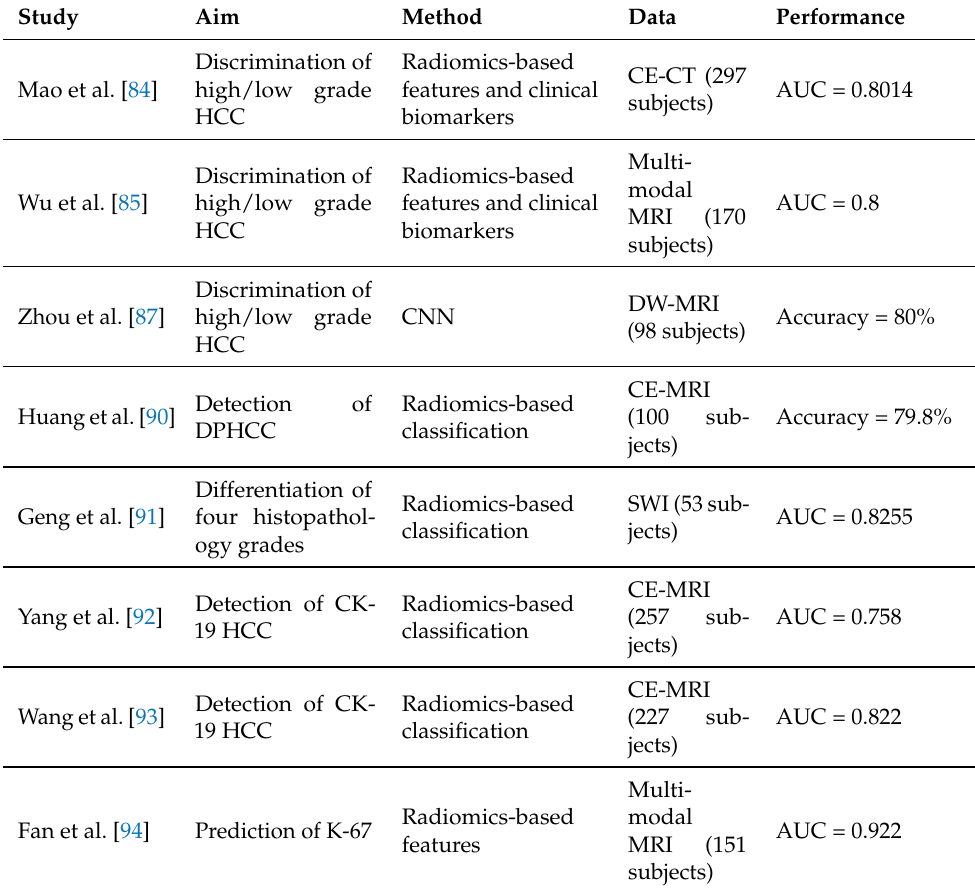
Table 4. HCC grade and molecular